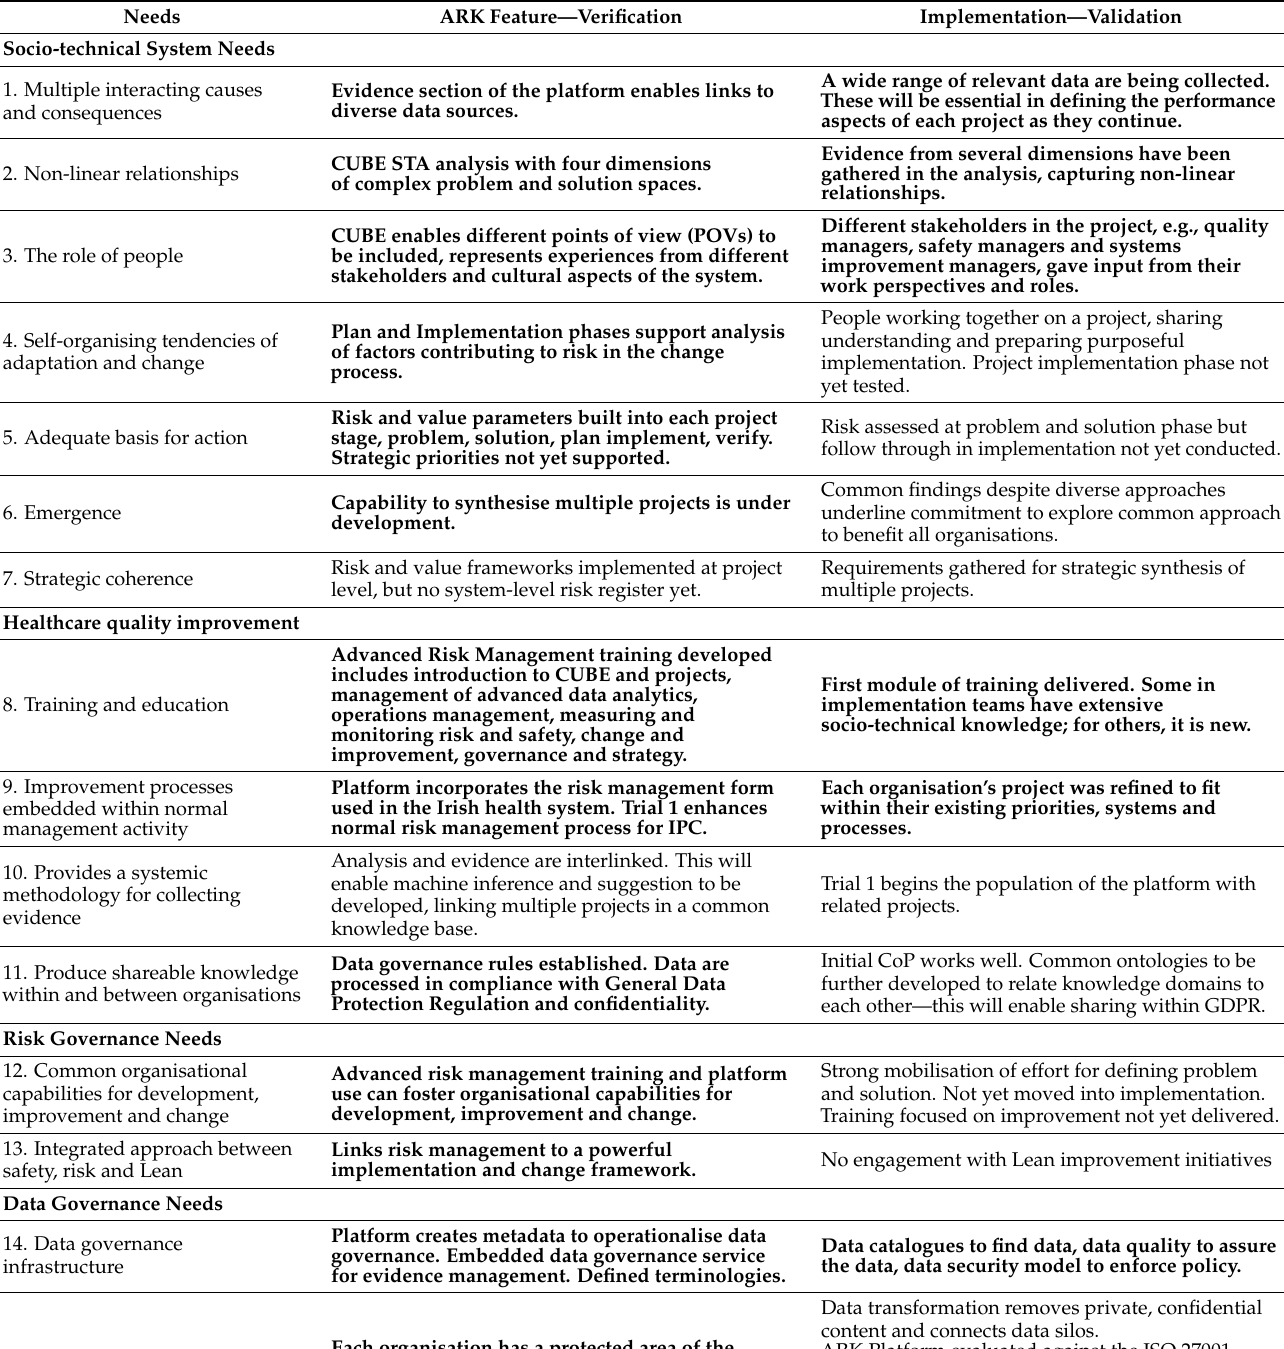
Table 3. Elements of a fully systemic approach to healthcare change management. Bolded text indicates the extent to which each element has been addressed in the ARK Platform (either verification or